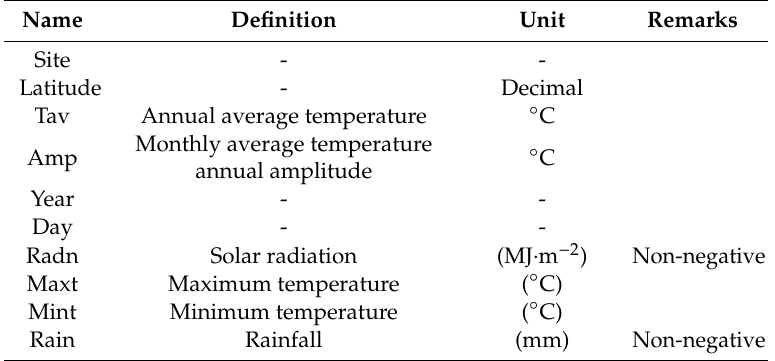
Table 4. Meteorological file data items of the APSIM (Agricultural Production Systems sIMulator) sugarcane model.